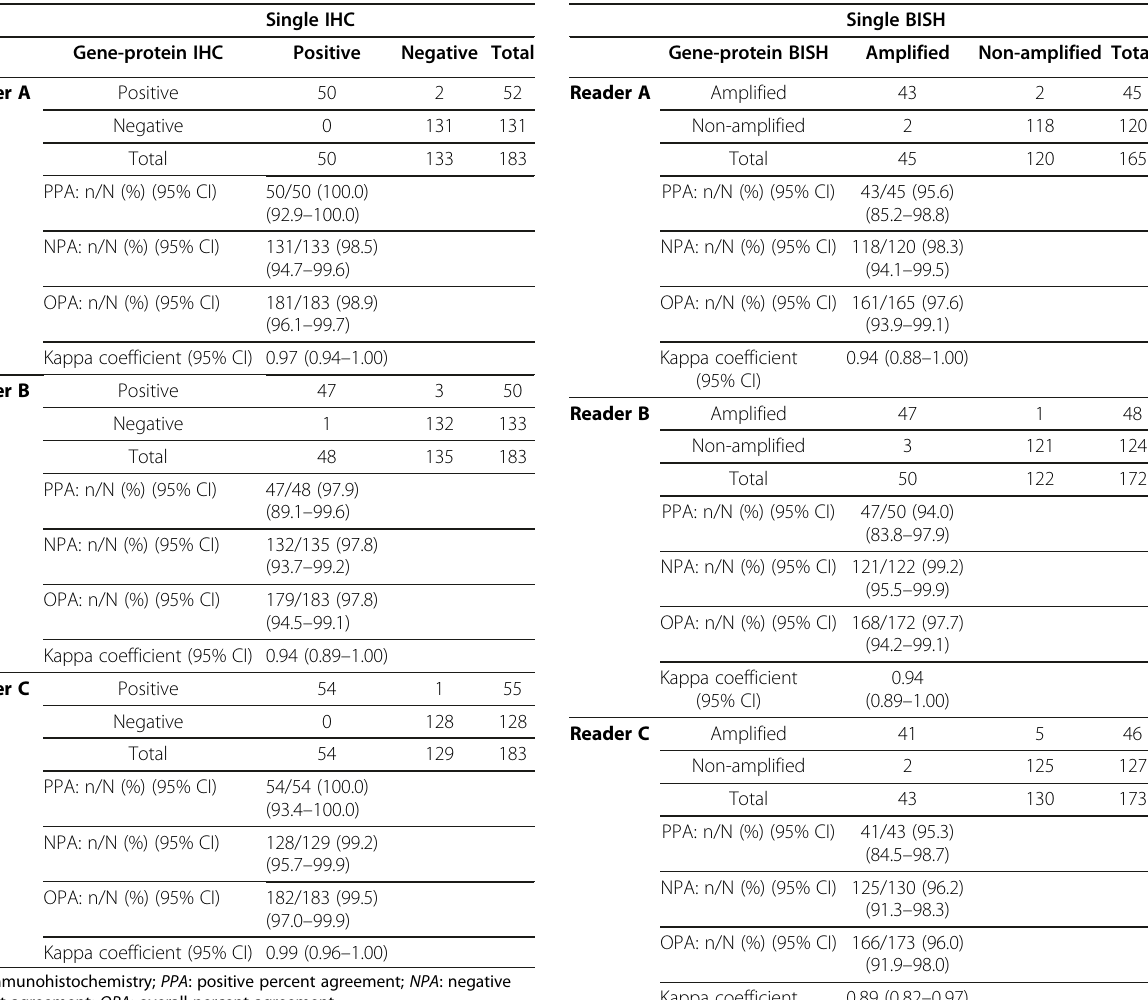
Table 5 Gene-protein IHC (comparator) vs. single IHC (reference) agreement analyses